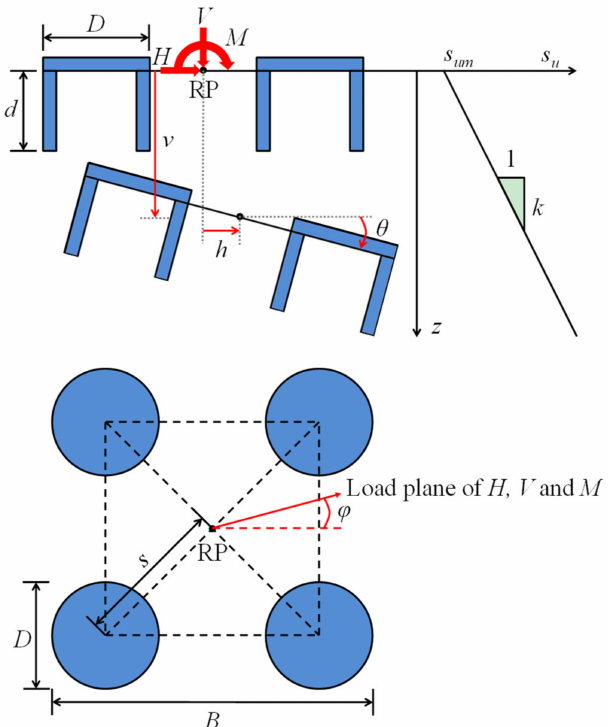
Figure 2. The geometric dimensions of tetrapod bucket foundations, common conventions of loadings and displacements and spatial distribution of undrained soil shear